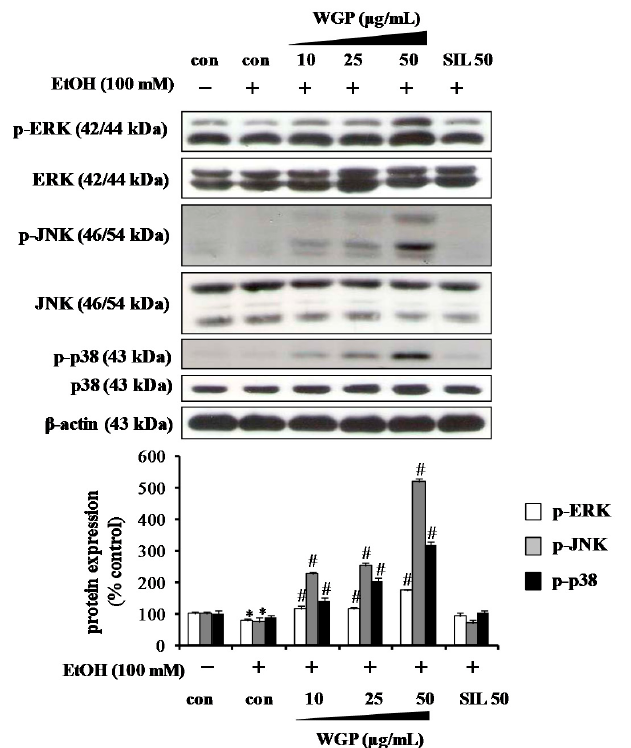
Figure 4. Effects of WGP on phosphorylation of mitogen activated protein kinases (MAPKs) in ethanol-treated HepG2 cells. Cells were pretreated with vehicle or WGP for 1 h before incubating with ethanol (100 mM) for 1 h. Values are the mean of three independent experiments ± SD ( n = 3). * p < 0.05 indicates differences from the unstimulated-control group; # p < 0.05 indicates differences from the ethanol-treated group.